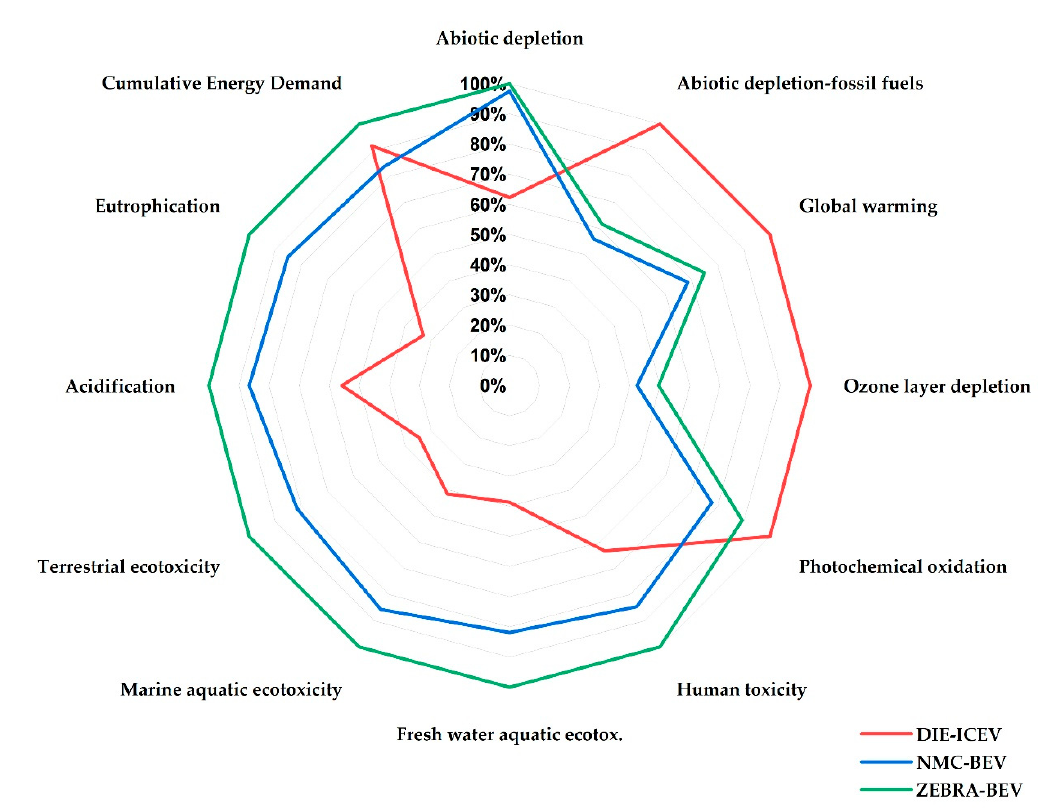
Figure 7. Comparison of the environmental performances of NMC111-BEV, ZEBRA-BEV, and DIE-ICEV. The impacts were normalised to the highest score in each category; only the vehicle/battery manufacturing and use stages are included.